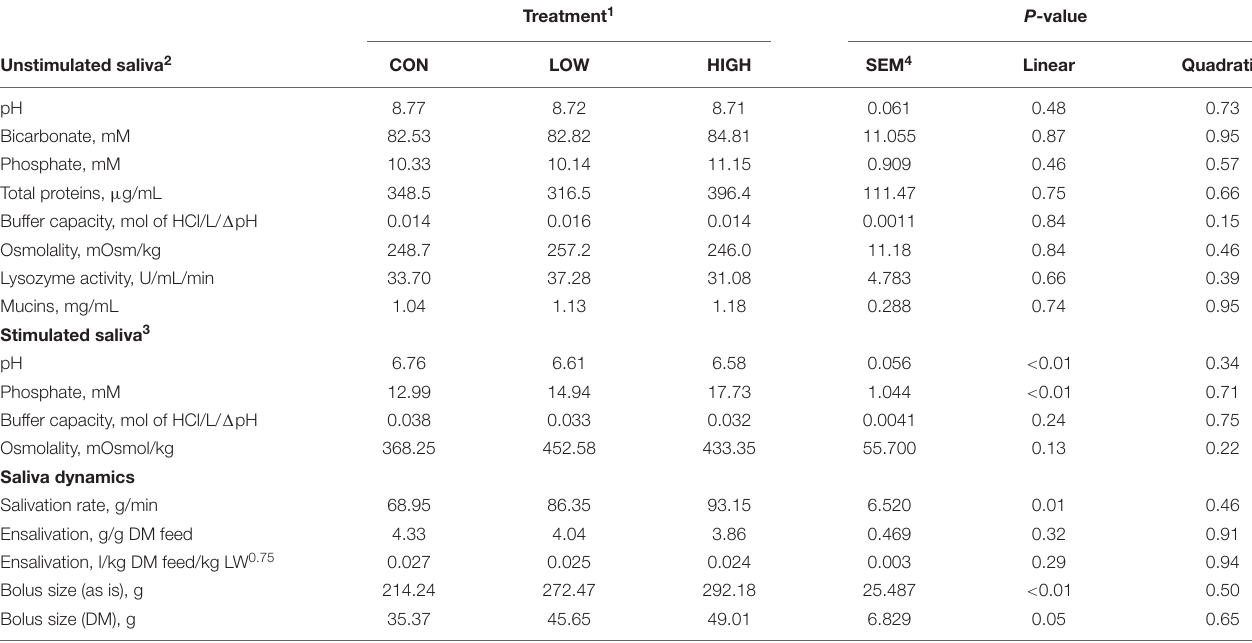
TABLE 6 | Effect of supplementation with ginger on salivary physico-chemical properties, and feed bolus dynamics of non-lactating Holstein dairy